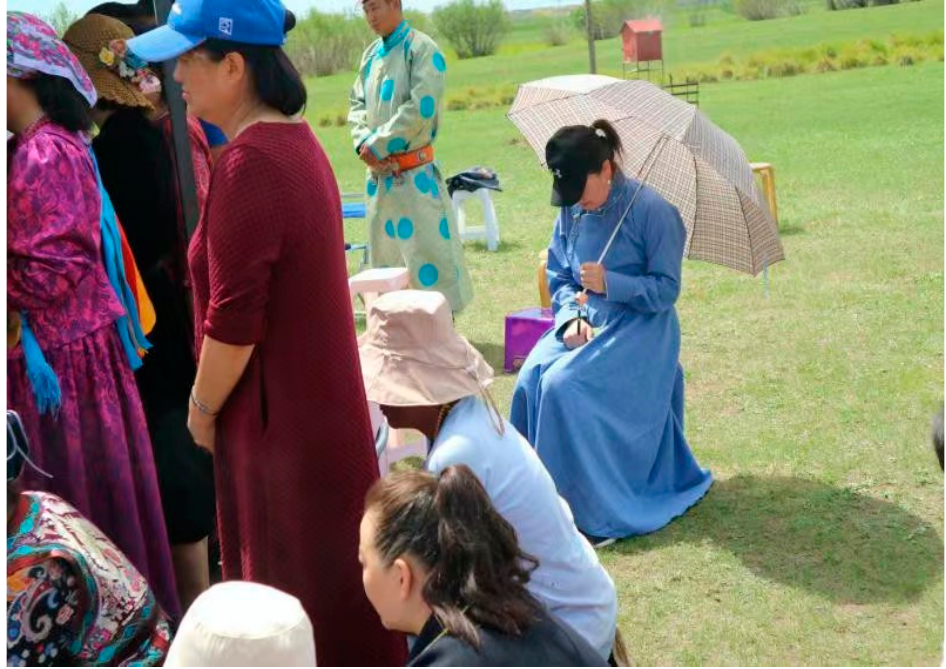
Figure 2. Women are moved to tears by shaman Siqinggua in the state of connecting earth and heaven in the Ominan ritual. Photograph by Liu Xiaoshuang, 30 September 2020.